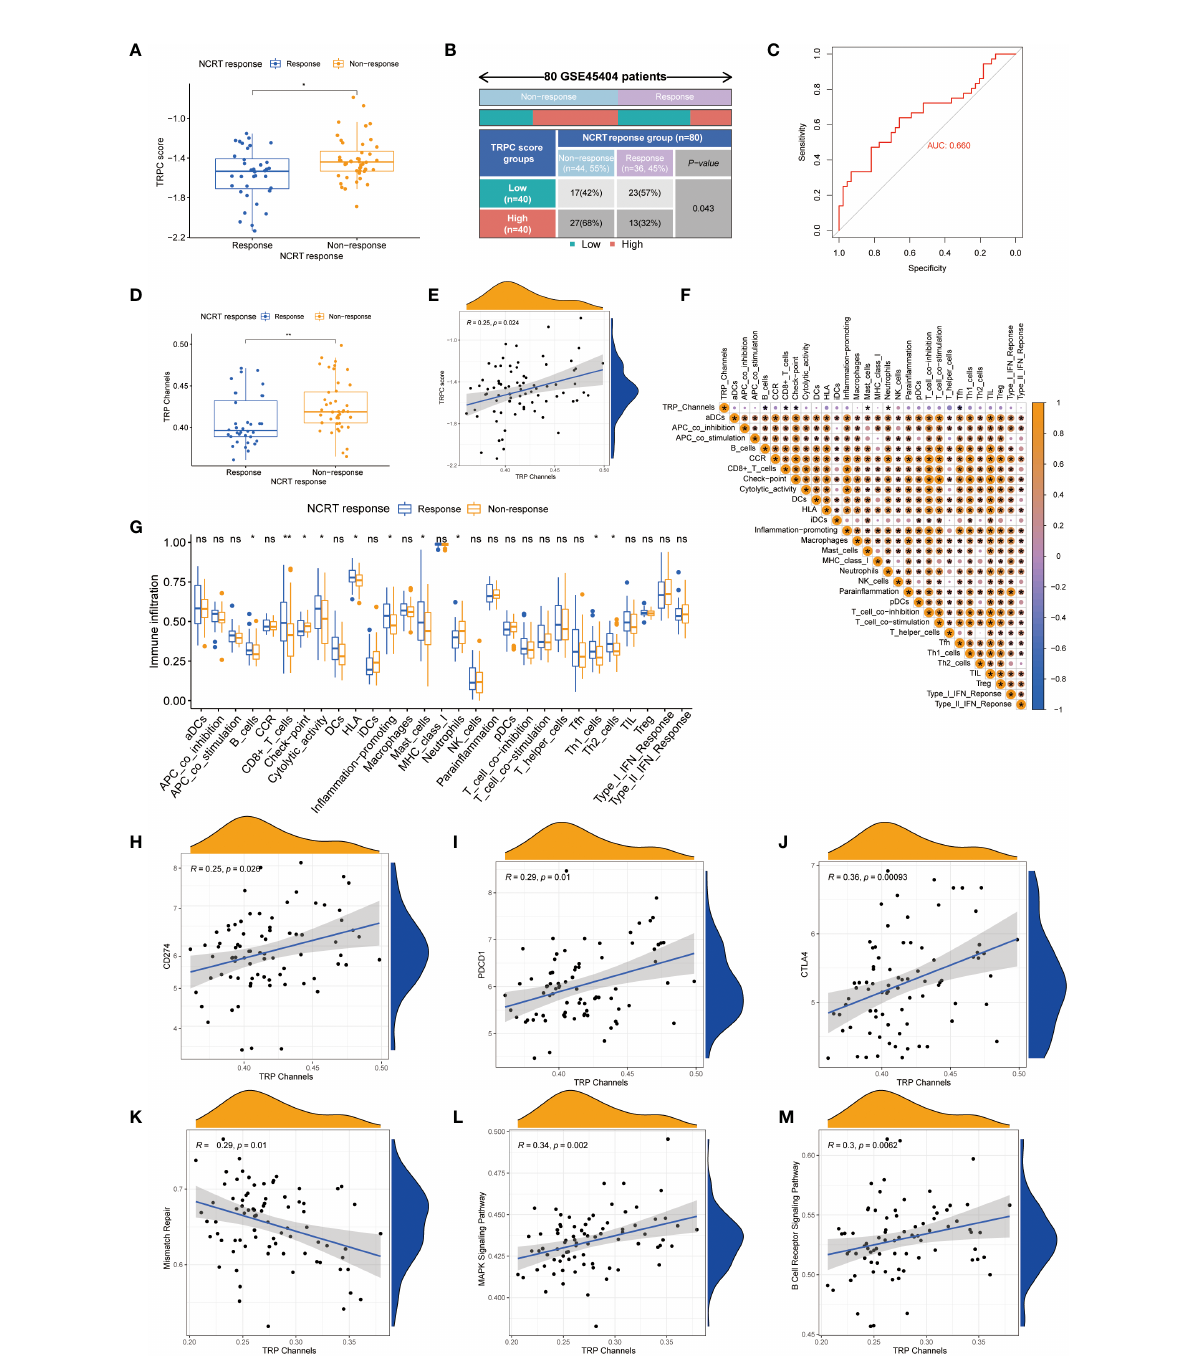
FIGURE 7 Correlation between TRPC score and response to NCRT in the GSE45404 cohort. The scatter diagram of the TRPC score between response and non-response group (A) , and fourfold table between TRPC score and NCRT response (B) . (C) ROC curve of TRPC score to predict NCRT response. (D) The distribution of the TRPC activity between response and non-response group. (E) Scatter plot showed the association between the TRPC activity and TRPC score. (F) Heat map of correlation between the TRPC activity and immune in fi ltration. (G) ssGSEA scores of immune cells and immune-related functions between response and non-response group. (H-J) Scatter plot showed the association between immune checkpoints (e.g., PD-1, PD-L1, and CTLA4) and the TRPC activity. (K-M) Scatter plot showed the association between signaling pathway (e.g., mismatch repair, MAPK signaling pathway, and B cell receptor signaling pathway) and the TRPC activity. NCRT, neoadjuvant chemoradiotherapy; ROC, receiver operator characteristic; ssGSEA, single sample gene set enrichment analysis; TRPC, transient receptor potential channels; ns, not signi fi cant; *P< 0.05; **P<